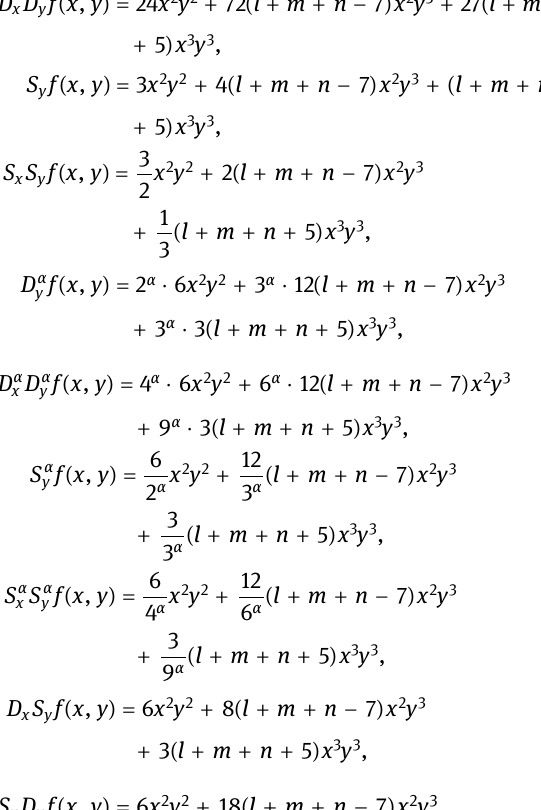
Table 3: Edge partition